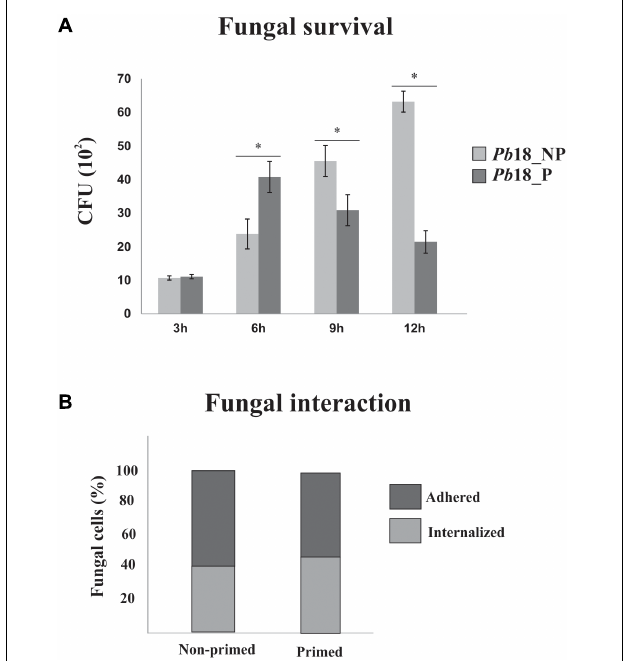
FIGURE 1 | P. brasiliensis , Pb 18 infection in alveolar macrophages. (A) Recovery of P. brasiliensis fungal cells after interaction with primed and non-primed macrophages. P. brasiliensis , Pb 18 was recovered from AMJ2-C11 primed ( Pb 18_P) and non-primed ( Pb 18_NP) alveolar macrophages, by INF- γ after: 3, 6, 9, and 12 h of interaction. The viable yeast cells recovered from macrophages were determined based on the number of CFUs. The error bars indicate the mean ± standard deviation of the values obtained from the triplicate of independent experiments. ∗ , Significantly different results; P -value ≤ 0.05. (B) Percentage of adhered and internalized fungal cells after interaction with primed and non-primed macrophages. The interaction assay was performed in glass slides; fungi cells were washed, fixed, and stained with Giemsa. A total of 600 macrophages were